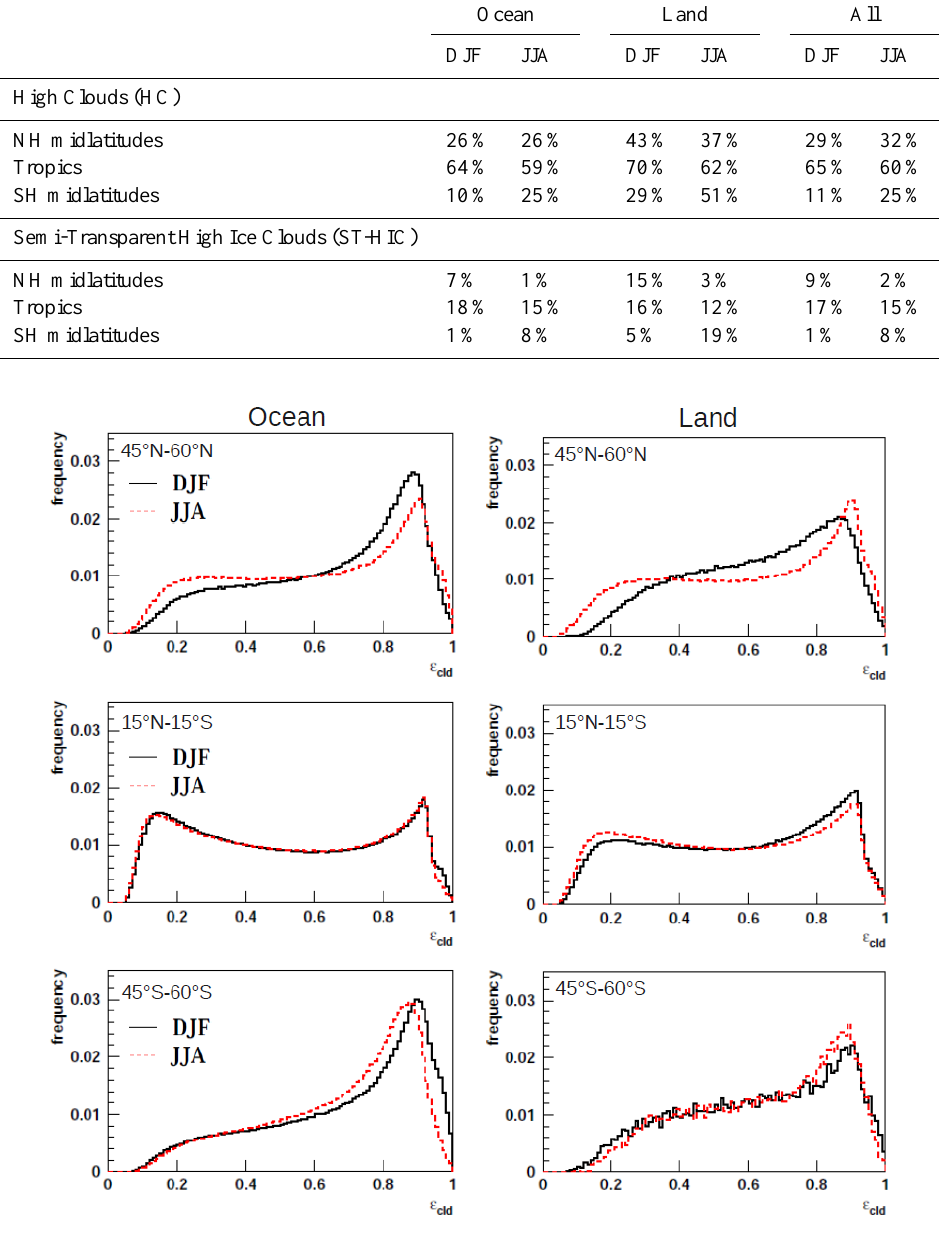
Fig. 6. Normalized frequency distributions of high cloud emissivity over ocean (left) and over land (right), separately for three latitude bands. Boreal winter and boreal summer are represented with black and red lines, respectively. Statistics is over the period 2003 - 2009.